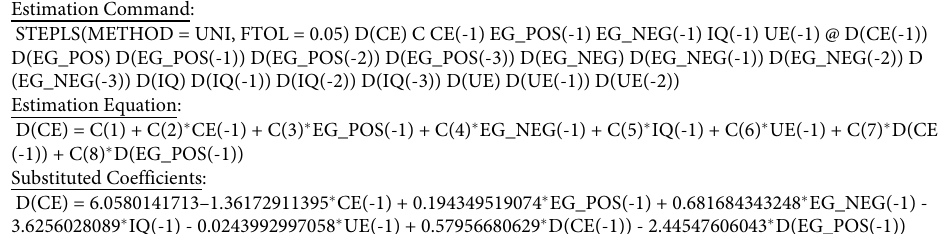
Table 6. Estimation command, equation, and substituted coefficients. Estimation